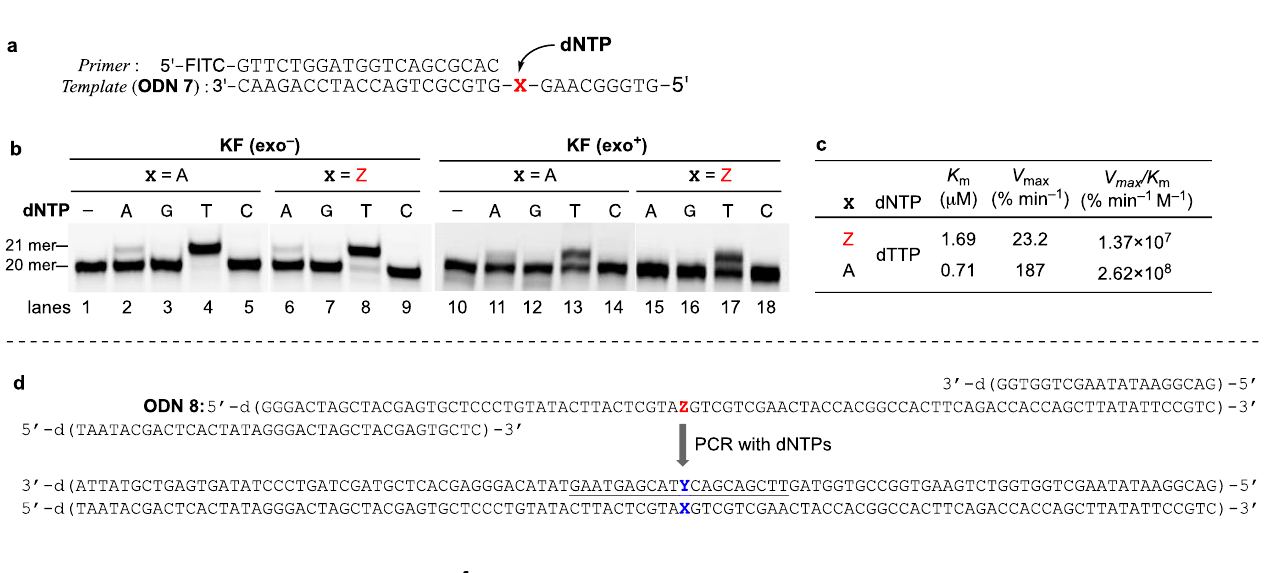
than against A in the template (Z:T pair, V max / K m = 1.37 × 10 7 ; A:T pair, 2.62 × 10 8 ). Never- theless, the parameters strongly suggested that the ambiguous Z-base functions as an A- like analog during replication by DNA polymerase, forming a pair with T. We also explored PCR amplification catalyzed Taq DNA polymerase with a DNA template containing Z-base. The experiment was carried out with an 87-mer template con- taining Z-base and two primers to give 104-bp amplicons (Figure 5d), and the resulting amplicons were sequenced to evaluate accumulated mutagenesis that occurred at the po- sition of Z-base. As shown in Figure 5e, the PCR for the template with Z-base in the middle of the sequence proceeded with efficiency comparable to that of the natural template, yielding nearly equal amounts of amplicons. In addition, sequencing of the amplified product verified that dTTP was incorporated against Z-base in the template as a